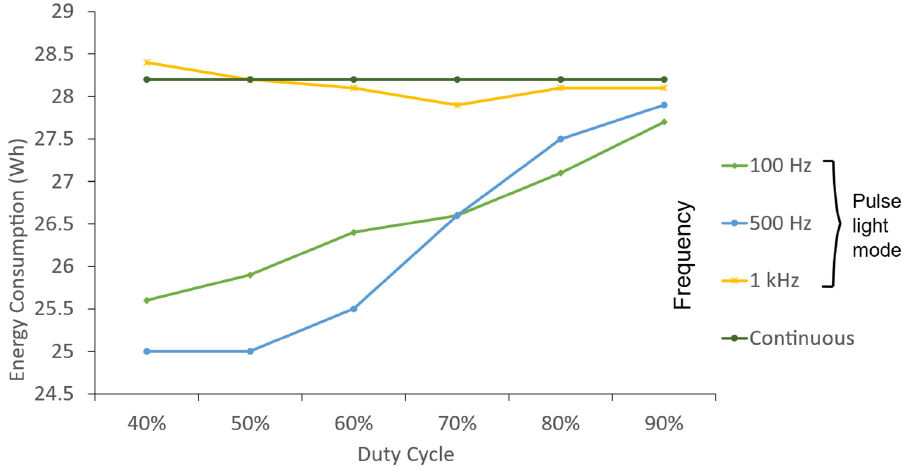
Figure 3. Energy consumption behavior for 95R5B light recipe at 110 µ mol m − 2 s − 1 with different pulsed frequencies and duty